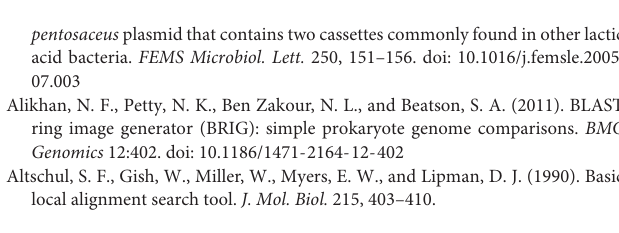
TABLE S3 | Prophages predicted in 57 P. pentosaeus strains using